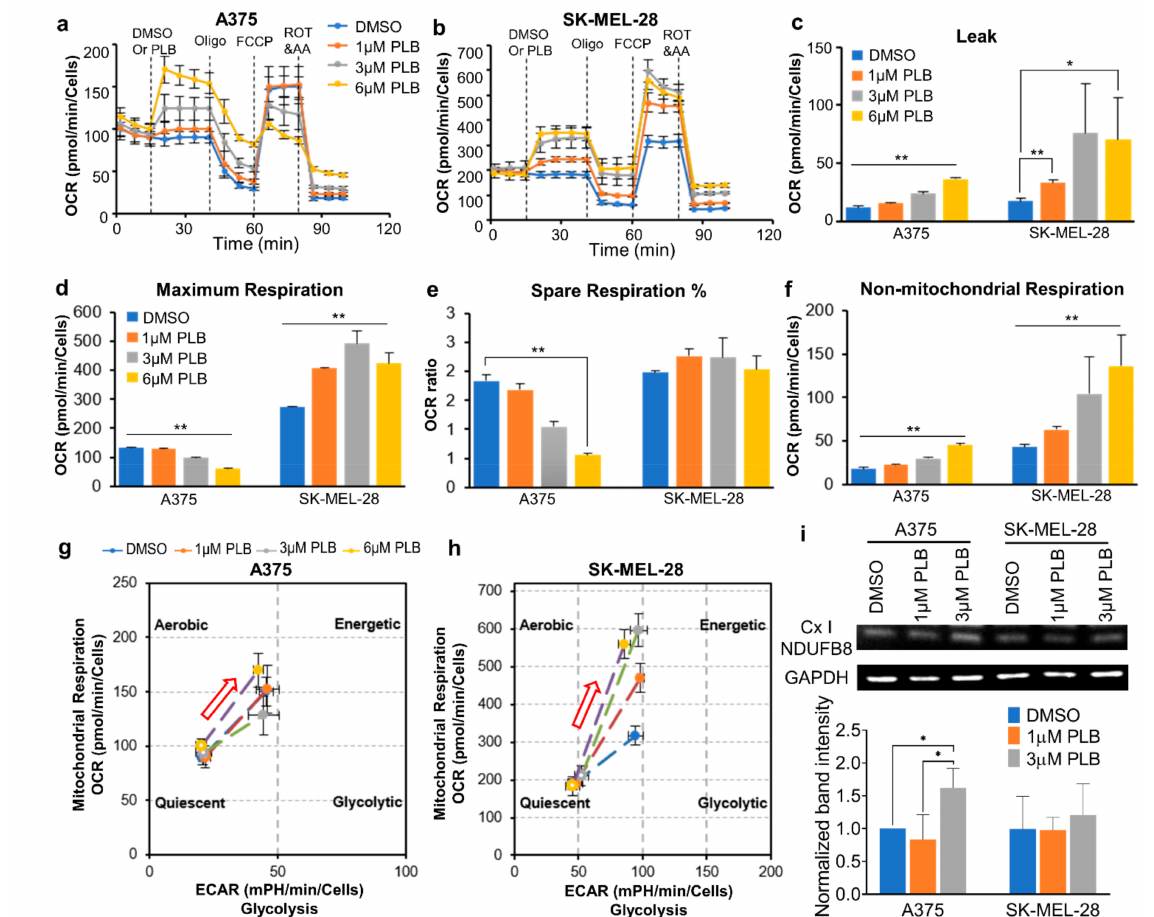
Figure 5. Mitochondrial respiratory function alternations due to PLB treatment. Melanoma cells were seeded in the seahorse XF96 cells culture microplates at a density of 2 × 104. DMSO and 1, 3, and 6 µ M PLB were acutely applied in the Seahorse machine with the following injection of Oligo, FCCP, ROT, and AA ( n = 3–8). ( a ) OCR of A375 cells. ( b ) OCR of SK-MEL-28 cells. ( c ) Proton leak. ( d ) Maximum respiration. ( e ) Percentage of spare respiratory capacity. ( f ) Nonmitochondrial respiration. ( g ) Energy map of A375. Red arrow shows the direction of PLB-induced energy change. ( h ) Energy map of SK-MEL-28. Red arrow shows the direction of PLB-induced energy change. ( i ) Western blot results show the expression of NDUFB8 subunit of mitochondrial Cx I with DMSO and 1 and 3 µ M PLB treatment. The bar figure displays the normalized results compared with the expression of GAPDH ( n = 3). Results are expressed as mean ± SD. * p < 0.05, ** p < 0.01. GAPDH, glyceraldehyde 3-phosphate dehydrogenase. NDUFB8, ubiquinone oxidoreductase subunit